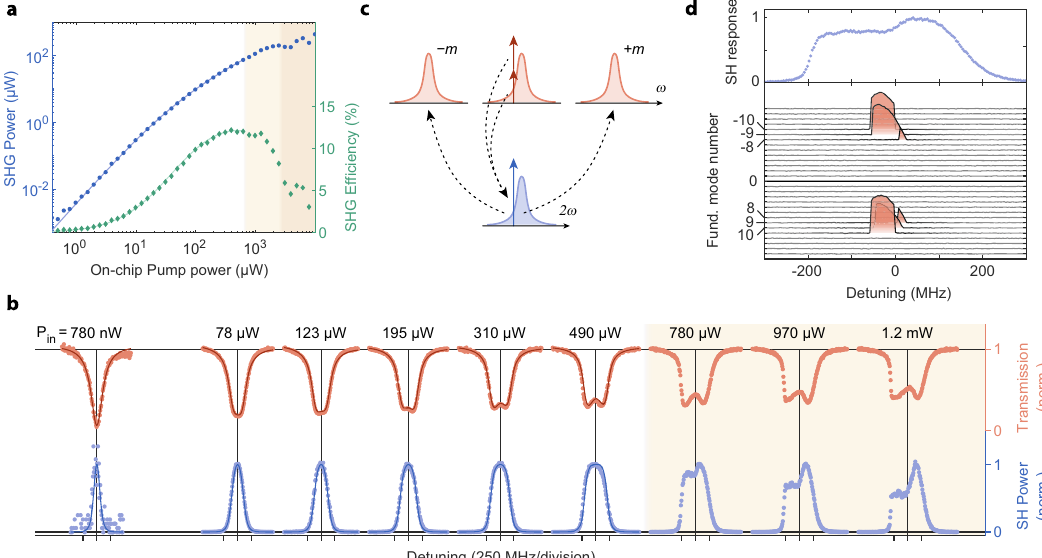
Fig. 4 Second harmonic generation and cascaded OPO. a 774.7 nm output power as a function of 1549.4 nm input power (blue circles, left axis) and SHG ef fi ciency (green diamonds, right axis). Solid lines represent theoretical prediction. Light yellow shading corresponds to the region where we observe cascaded OPO. Darker shaded region have competing third-order nonlinear processes. b Transmission (top) and SH (bottom) lineshapes evolve as a function of power. We plot theoretical curves (solid lines) on the top of data (red and blue points) up to the limit where the two-mode model breaks down